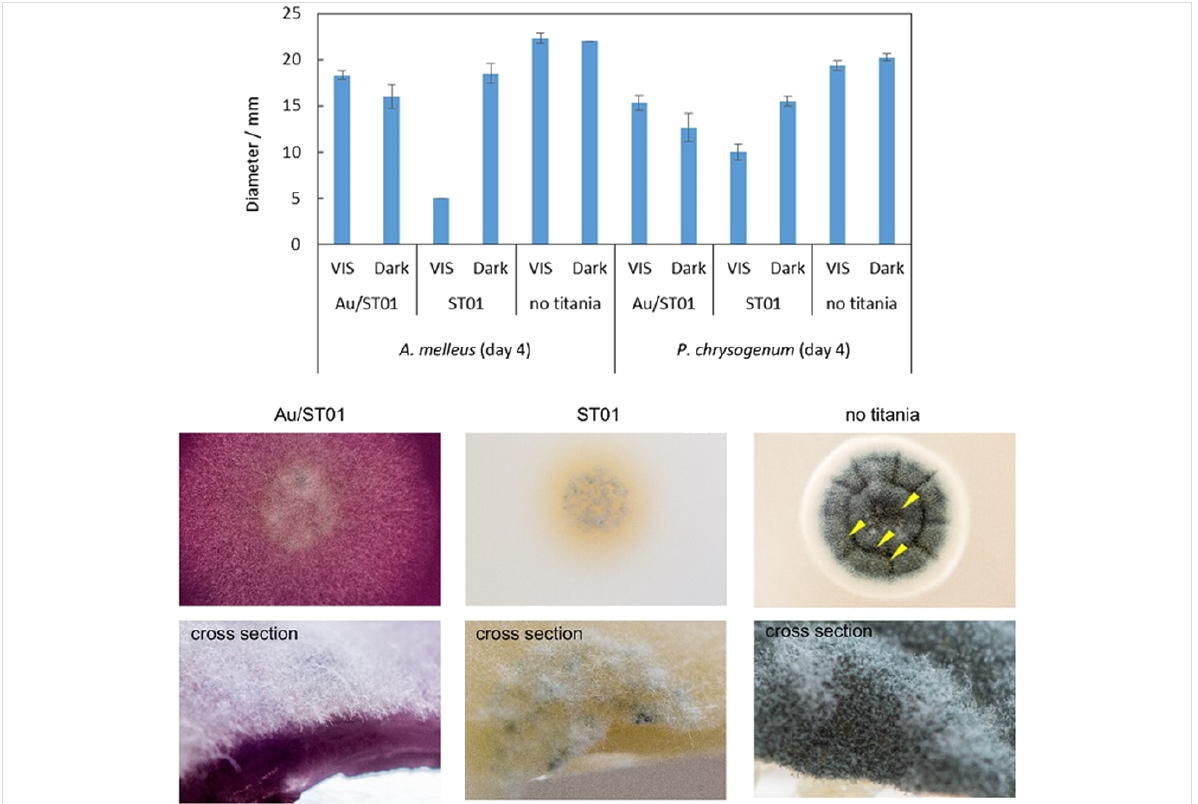
Figure 7: (top) Antifungal properties of bare and gold-modified titania ST01 by a comparison of diameters of colonies after four days of growth ( n = 6, mean ± S. D.), and (bottom) representative photograph of P. chrysogenum cultivated for four days under fluorescent-light irradiation. Arrowheads indi- cate the droplets.